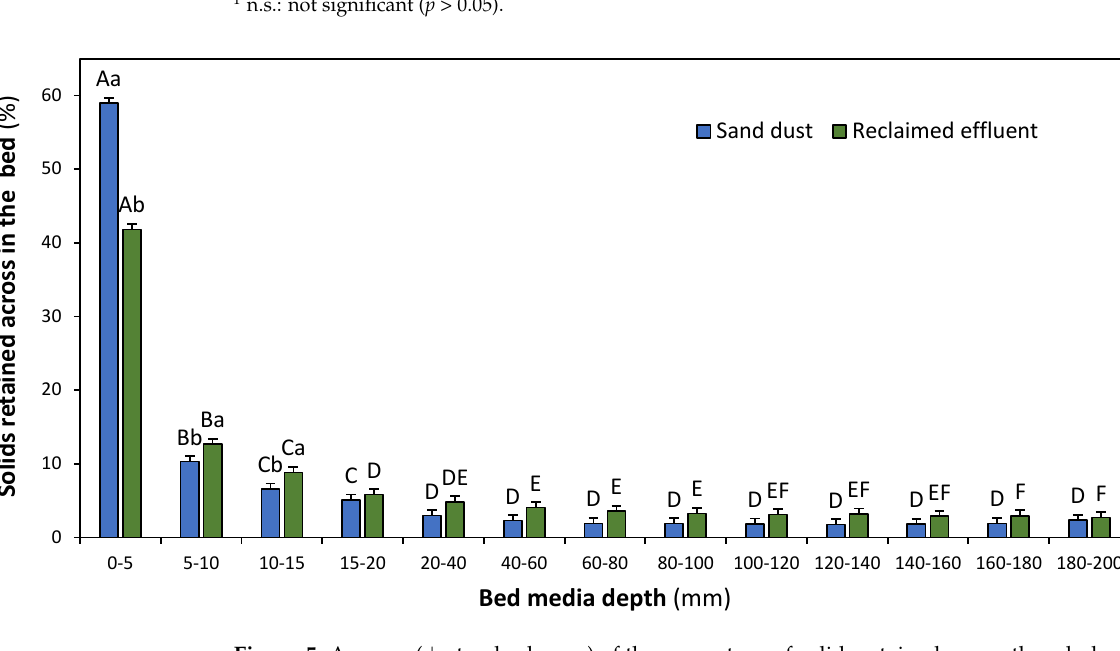
Figure 5. Average ( ± standard error) of the percentage of solids retained across the whole media bed in each slice of bed regarding the type of particles added. Different small letters show significant differences ( p < 0.05) between sand dust and reclaimed effluent for a given bed slice. Different capital letters mean significant differences ( p < 0.05) between bed slices for a given type of particle added.